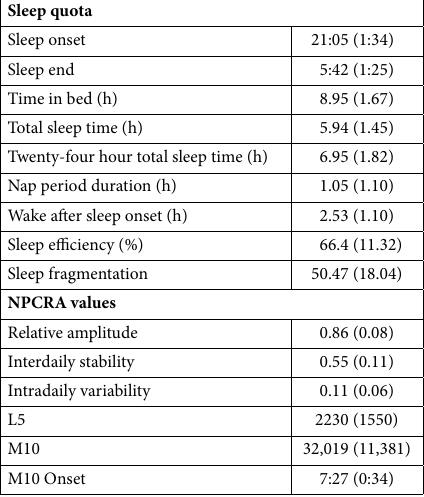
Table 1. Descriptive sleep quotas (n = 51, men = 23) and NPCRA analysis (n = 31, men = 17) of the BaYaka from actigraphic analysis. Overall age range is 17–72 years. Data are reported as mean (standard deviation). Nap period duration was calculated by subtracting TST from TTST. L5 is the activity during the 5 h of least activity during the diel cycle. M10 is the activity during the most active 10 h during the diel